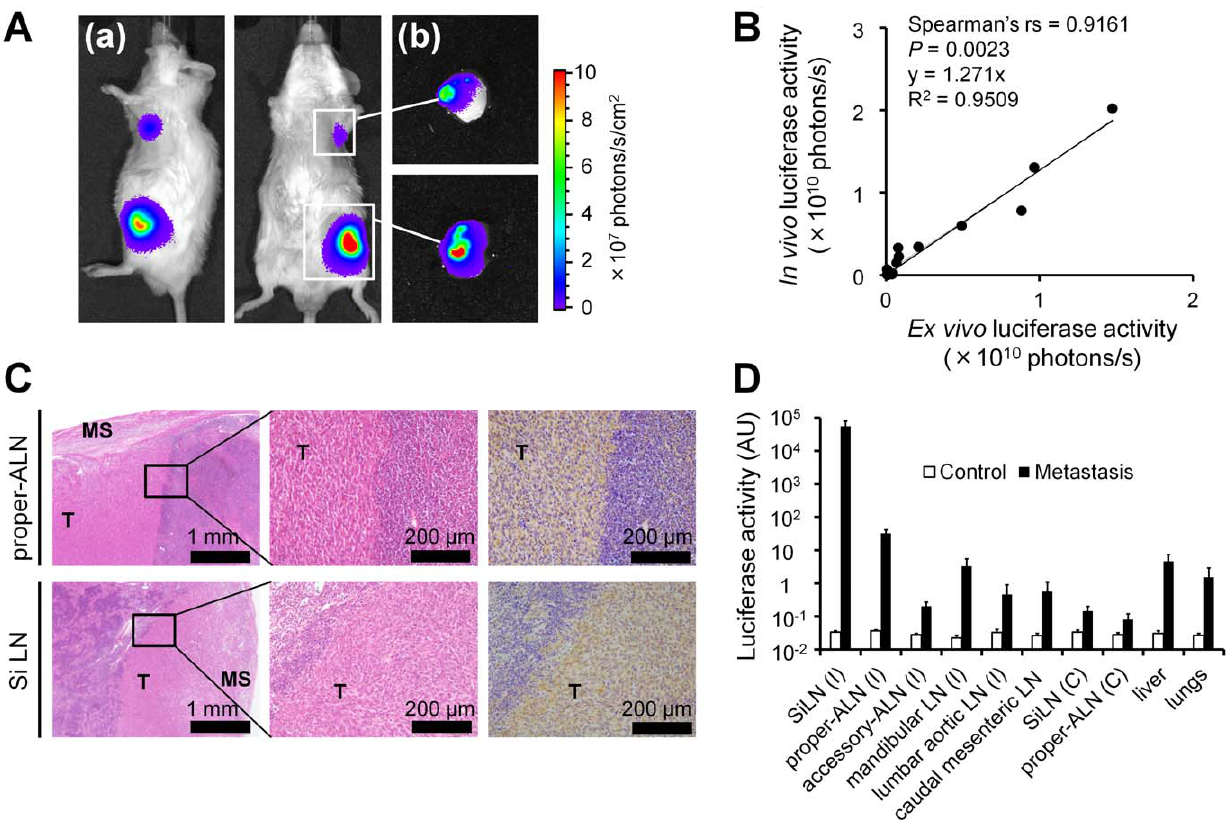
Figure 2. Establishment of the model of lymph node metastasis. A. Representative images captured by in vivo bioluminescence imaging of a mouse with tumor cells grafted into the SiLN to promote metastasis to the ALN. ( a ) In vivo and ( b ) ex vivo bioluminescence signals in the proper-ALN and SiLN on day 14 post-inoculation, indicating that the proper-ALN is the draining lymph node. B. Graph showing the high correlation between in vivo and ex vivo bioluminescence ( P =0.0023; Spearman’s rank correlation coefficient [rs] =0.9161; SiLN, n =6; proper-ALN, n =6). C. Results of histological verification. Tumor cells stained with H&E and luciferase-positive immunohistochemical signals in the proper-ALN and SiLN. MS: marginal sinus. T: tumor. D. Dissemination of KM-Luc/GFP cells (metastasis, n= 4) or PBS alone (control, n= 3) to each organ, assessed on day 14 post-injection of the SiLN. I, ipsilateral; C, contralateral; LN, lymph node. Error bars indicate the SEM values.